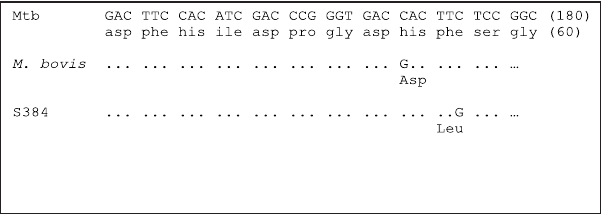
Figure 3) Position of missense mutation in pncA gene of S384. Partial nucleotide sequence of the pncA gene from Mycobacterium tuberculo- sis strain Erdman (Mtb) is shown on the top line with the amino acid sequence beneath it. The point mutations in Mycobacterium bovis and S384 are indicated with their corresponding amino acid changes. Se- quence of the Erdman and M bovis strains and nucleotide and amino acid numbering are those of Scorpio and Zhang (25). ‘.’ indicates nu- cleotide sequence identical to that of the Erdman